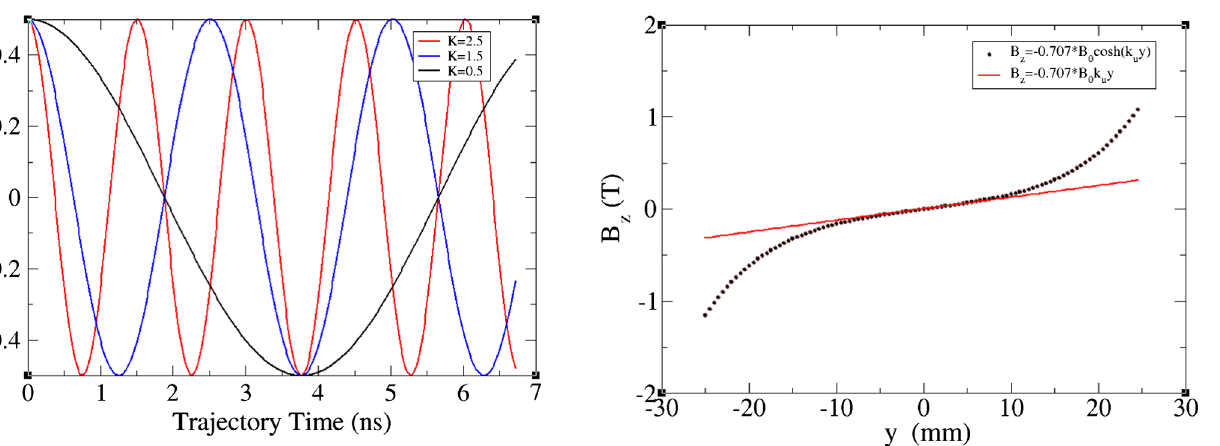
FIG. 1. Betatron motion of an electron ( E ¼ 8 MeV) injected 0.5 mm off-axis for different K.